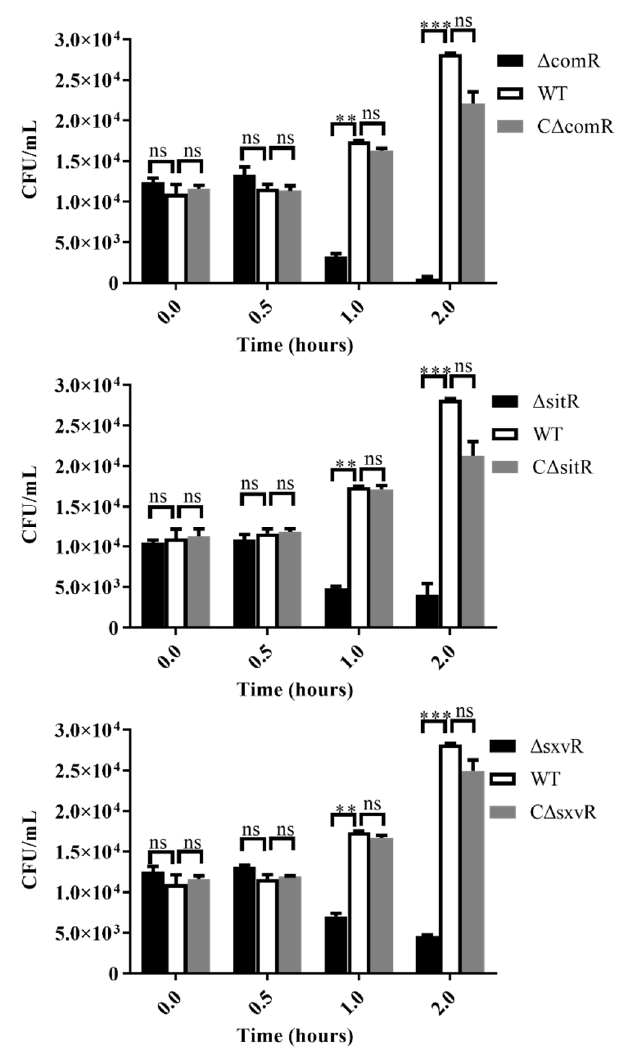
Figure 4. In vitro bacterial survival in the presence of mouse whole blood. SS2 WT, ∆ comR , C ∆ comR , ∆ sitR , C ∆ sitR , ∆ sxvR , and C ∆ sxvR stains were cultured to mid-log phase (OD600 of 0.6). Bacteria were then suspended in PBS, and subsequently, 900 µ L of whole blood was mixed with 100 µ L of SS2 cells and incubated for 2 h at 37 ◦ C. The incubated mixtures were harvested at 0, 0.5, 1 and 2 h, serially diluted, vortexed, and plated on tryptic soy agar plates to determine the number of bacteria. The assays were performed in triplicate and repeated three times. ** p < 0.01, *** p < 0.001, ns means no significance.